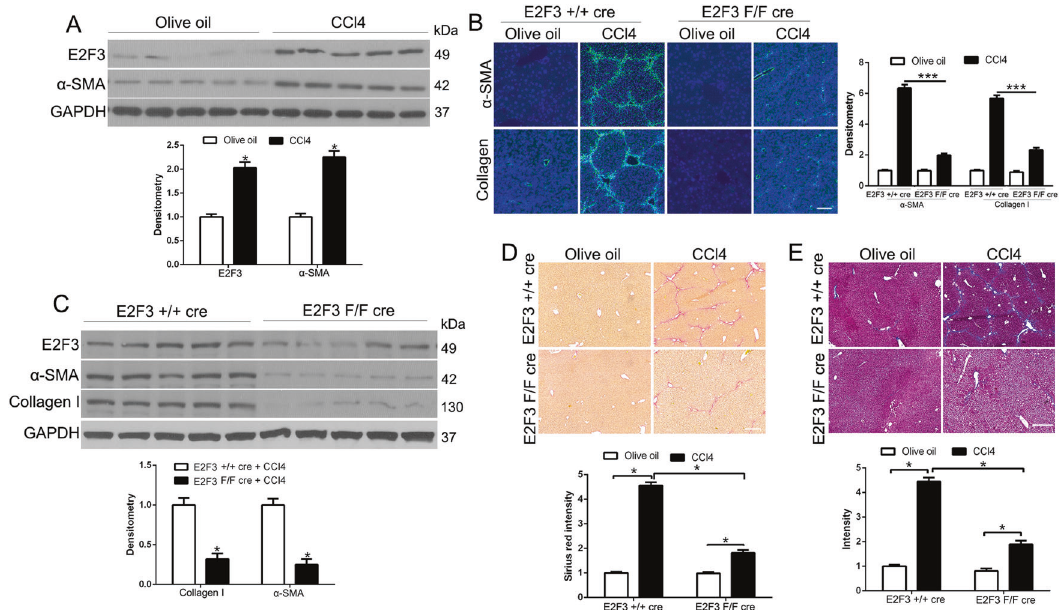
Fig. 8 CCl4-induced HSC activation and liver fi brosis are impaired in E2F3 F/F cre mice as compared to E2F3 + / + cre mice. A Livers of olive oil-treated mice or CCl4-treated mice were collected for WB. CCl4 treatment upregulated α -SMA and E2F3 in murine liver. Densitometry is shown on the bottom. * p < 0.05 by t -test. B E2F3 F/F cre mice and E2F3 + / + cre mice were treated with CCl4 for 6 weeks and their livers were. collected for IF for HSC activation markers and collagen I. Quantitative IF data are shown on the right. E2F3 F/F cre livers showed reduced α -SMA and collagen I level, as compared to E2F3 + / + cre livers after CCl4 treatment. * p < 0.05 by t -test. C CCl4-treated livers were subjected to WB and densitometry data were shown on the bottom. CCl4-treated E2F3 F/F cre livers contained reduced α -SMA and collagen I level as compared to E2F3 + / + cre livers. * p < 0.05 by t -test. D , E Sirius red staining and Trichrome staining of liver sections are shown. Collagen deposition was reduced in CCl4-treated E2F3 F/F cre livers as compared to E2F3 + / + cre livers. * p < 0.05 by t